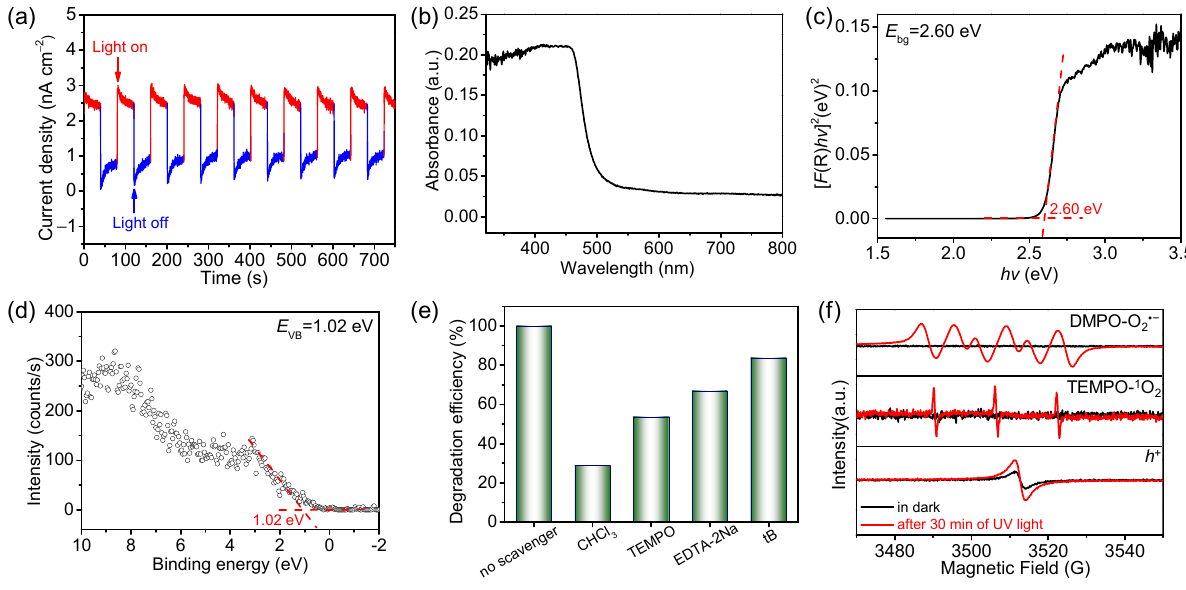
Figure 6. ( a ) Photocurrent responses, ( b ) UV–vis diffuse reflectance spectrum, ( c ) Tauc plot analysis, and ( d ) VB-XPS spectrum of COF-300; ( e ) Effect of scavengers on BB3 degradation efficiencies (TEMPO: 2,2,6,6-tetramethyi-1-piperidinyloxy; EDTA-2Na: ethylenediaminetetraacetic acid disodium salt; tB: tert-butanol); ( f ) ESR spectra for the detection of O 2 • – , 1 O 2 , and h + .